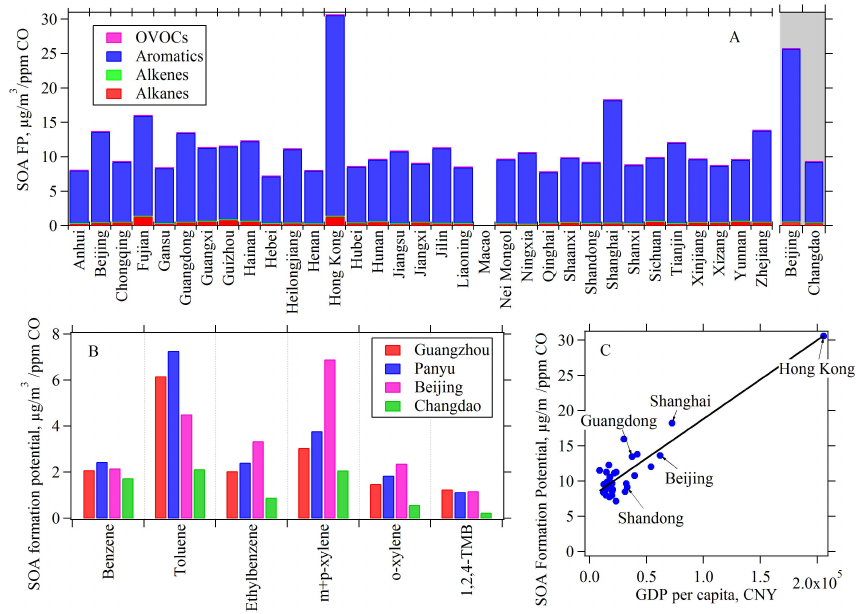
Fig. 9. (A) SOA formation potentials of VOC emissions calculated from initial emission ratios of VOCs to CO in the emission inventory of each province and from the results of field measurements (shaded areas) at an urban site in Beijing (Yuan et al., 2012) and during the Changdao campaign. (B) Comparison of SOA formation potentials of six aromatics at two sites in PRD (Guangzhou and Panyu) with those in Beijing and Changdao. (C) Scatterplots of SOA formation potential of VOC emissions in each province with gross domestic product (GDP) per capita in each